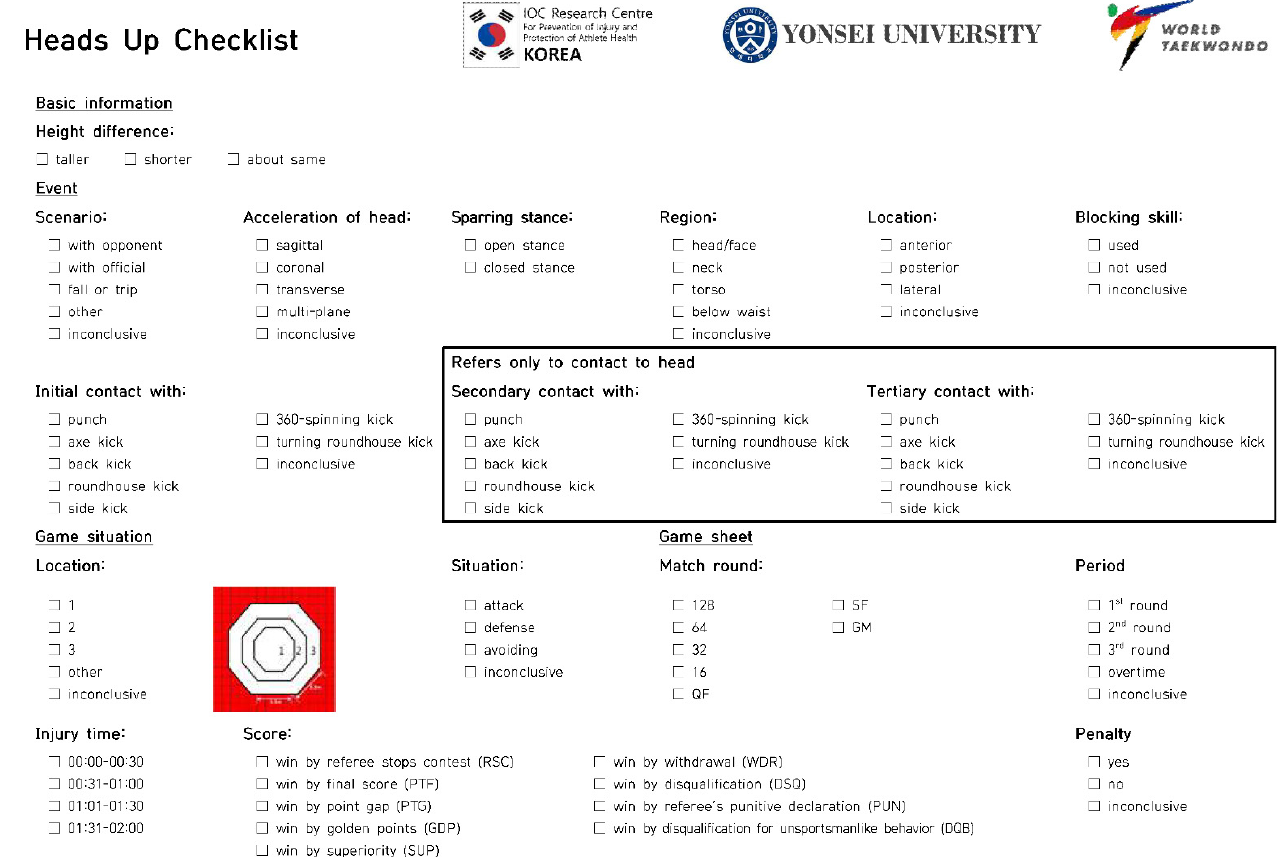
Figure 1. The modified Heads-Up